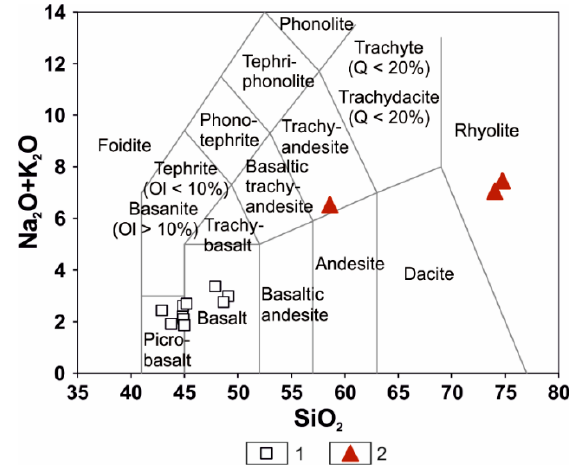
Figure 6. TAS diagram of [44] for the mafic (1) and intermediate-felsic (2) rocks.